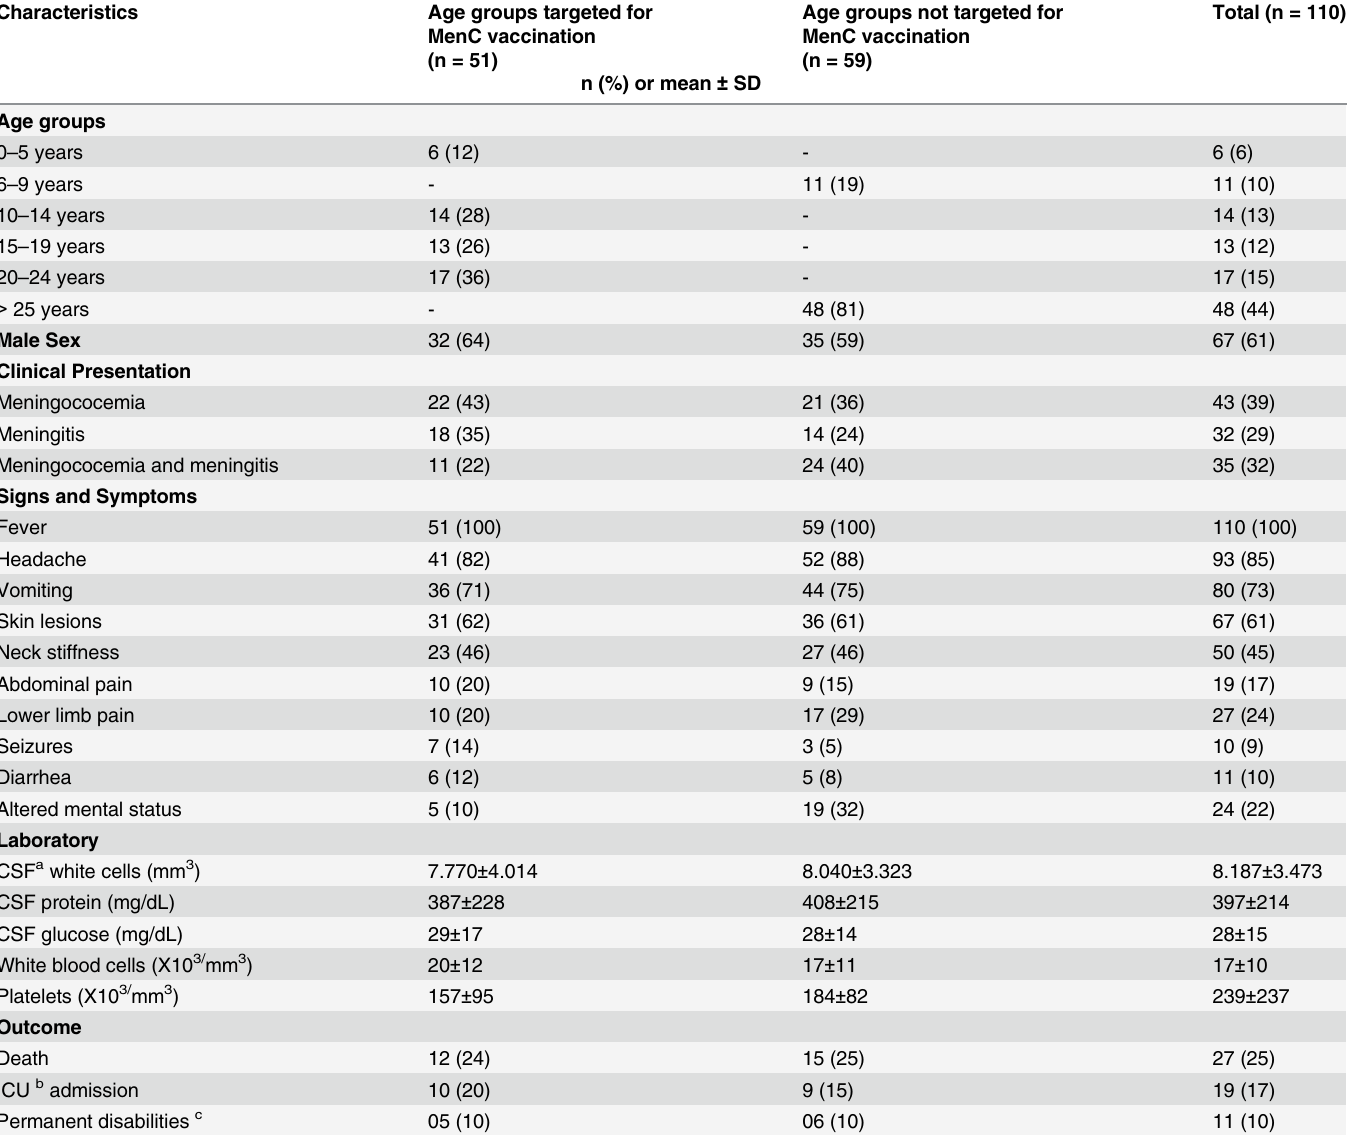
Table 1. Clinical characteristics of laboratory-confirmed cases of invasive meningococcal serogroup C disease, identified between 01/01/2010 and 31/12/2010 in Salvador, Brazil.